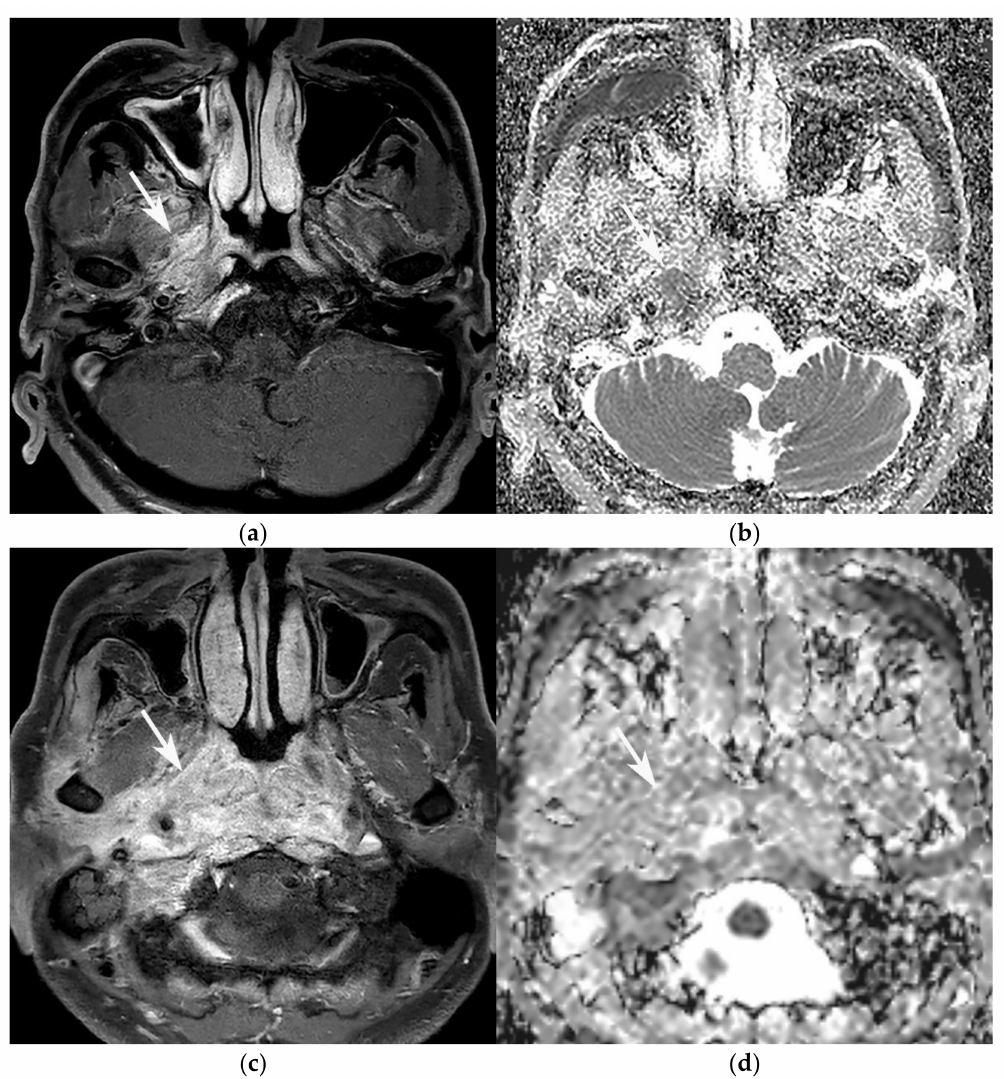
Figure 1. Comparison of ADC values between GPA lesion ( a , b ), and SBO lesion ( c , d ). ( a ) Axial contrast-enhanced T1WI of a 77-year-old male diagnosed with GPA shows infiltrative enhancing lesion (arrow) involving the right-side nasopharynx, parapharyngeal space, prevertebral muscle, and skull base. ( b ) His ADC map shows a relatively low ADC value inside the enhancing lesion (arrow). The measured value was 0.71 × 10 − 3 mm 2 /s. ( c ) On axial contrast-enhanced T1WI, a 79-year-old male diagnosed with SBO shows large area of infiltrative enhancing lesion (arrow) involving the nasopharynx, parapharyngeal space, carotid space, prevertebral and retropharyngeal space, skull base, and adjacent infratemporal fossa. ( d ) On his ADC map, the lesion shows relatively high ADC values inside the enhancing lesion (arrow), which was measured as 1.56 × 10 − 3 mm 2